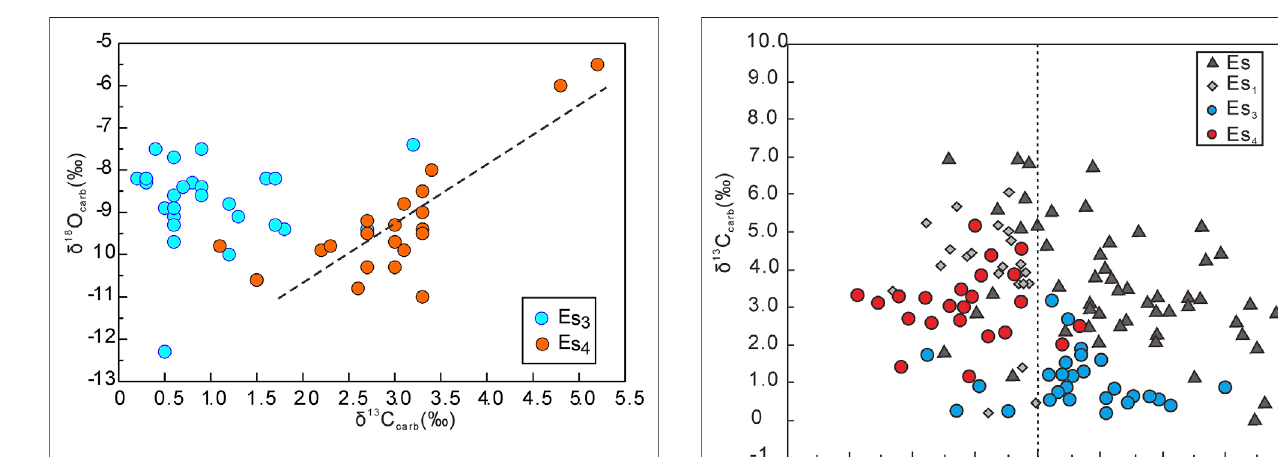
FIGURE 9 | Crossplot of δ 13 C Carb vs. δ 18 O Carb values in the lacustrine carbonates of the Langgu sag, Jizhong subbasin.